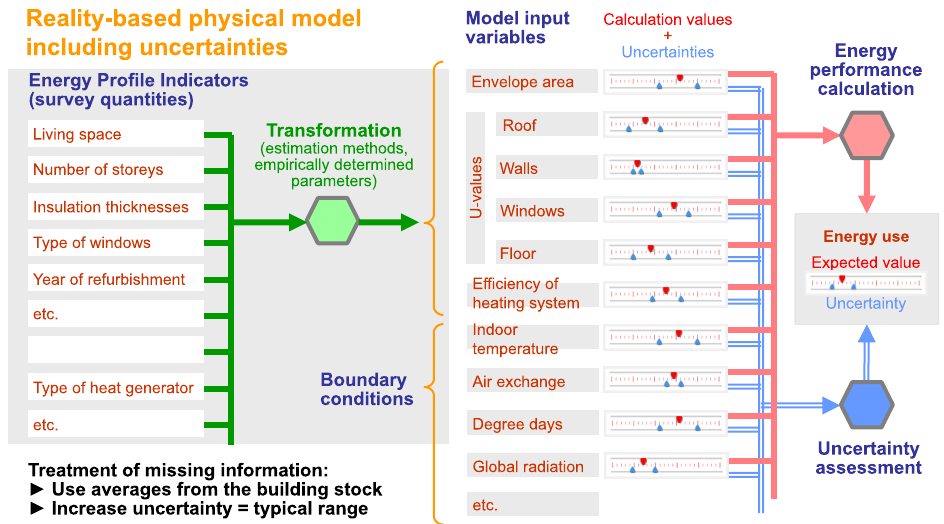
Figure 1. Principle of the combined physics-probability model based on energy profile indicators.